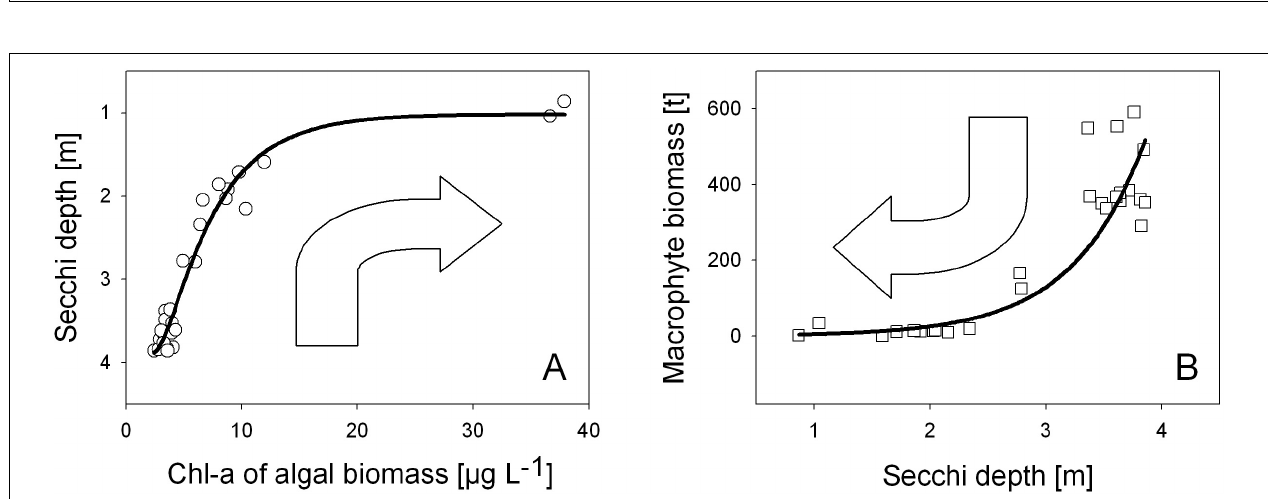
FIGURE 4 | The two sides of the same coin – the ecological perspectives of water transparency on photosynthetic organisms: Water transparency (A) as response function of phytoplankton biomass, where water turbidity decreases in the course of increasing algal biomass (measured as Chlorophyll- a in µ g L - 1 ) and (B) as light utilization factor controlling the growth of underwater macrophytes biomass as dry weight in t for the whole lake (B) . Water transparency is indicated by Secchi depth. Annual data from 1993 to 2019 (A) and 1993 to 2018 (B) .